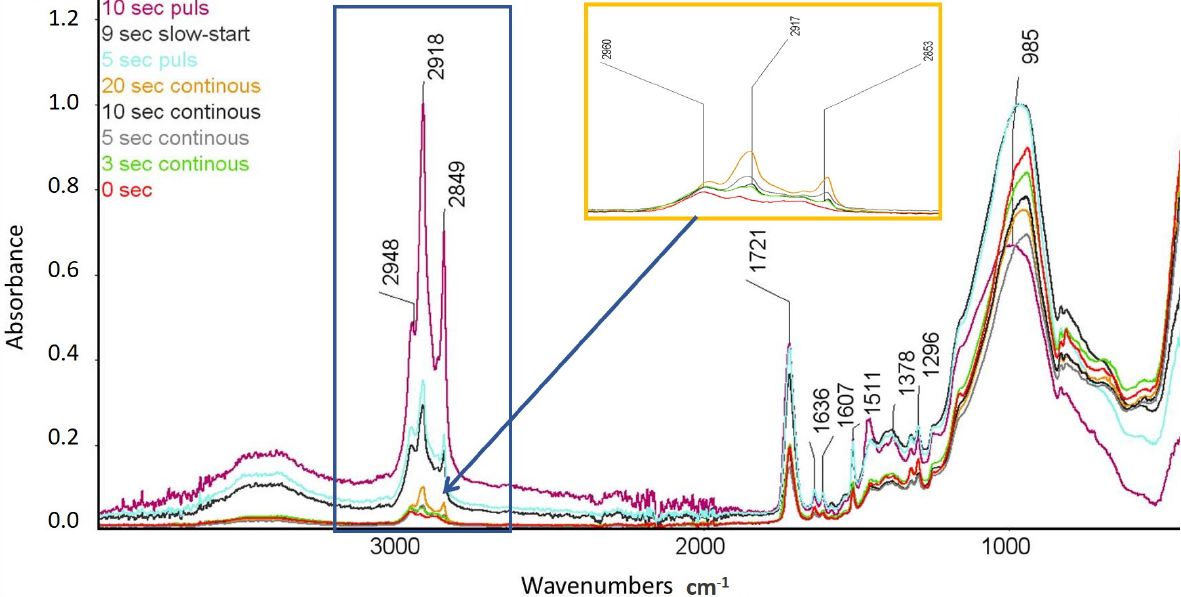
Figure 9. Comparison of the FTIR-ATR spectra of composites with the denoted bands involved in the photopolymerization process.